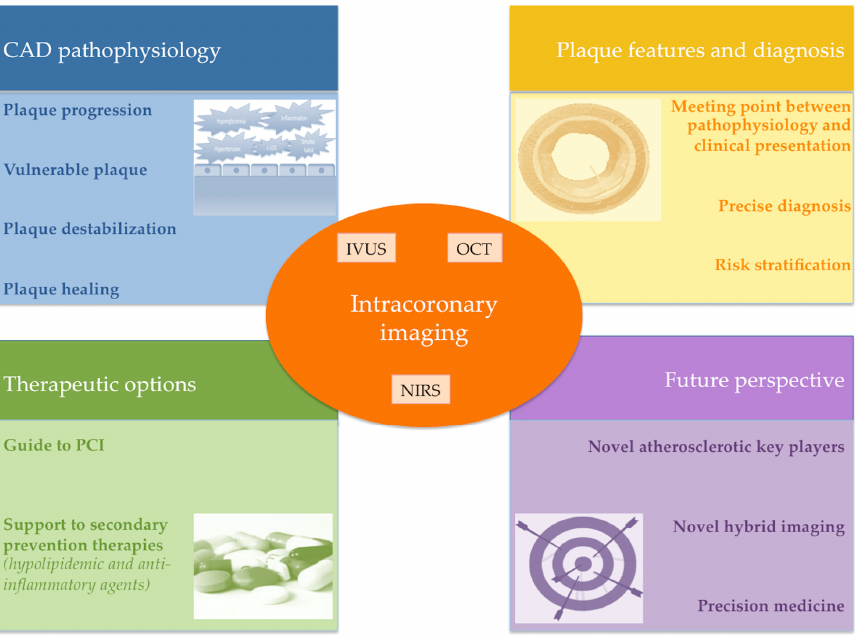
Figure 9. Graphical summary of clinical applications of intracoronary imaging.